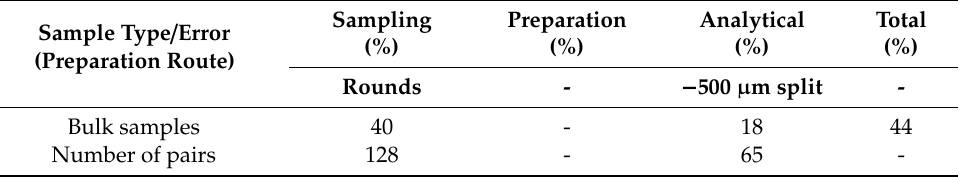
Table 20. Bulk sample duplicate pair